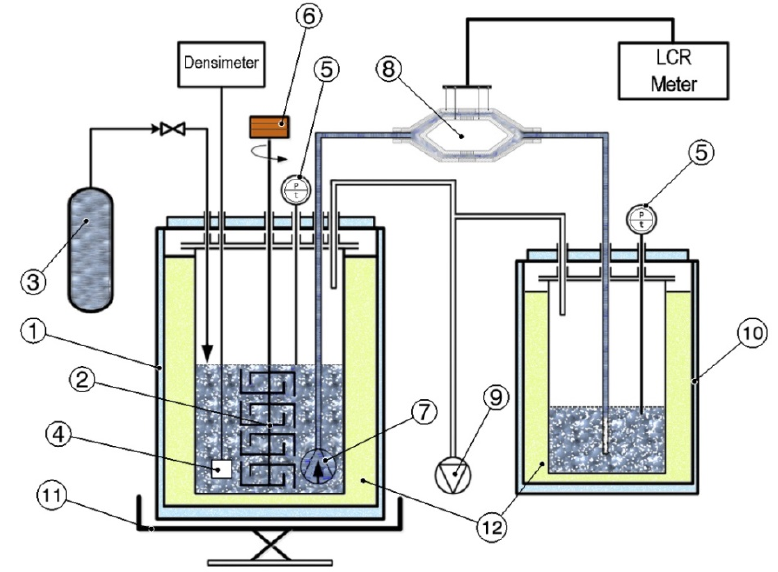
Figure 2. Schematic of the experimental set-up of slush flowmeter test rig: 1—Dewar slush forming,